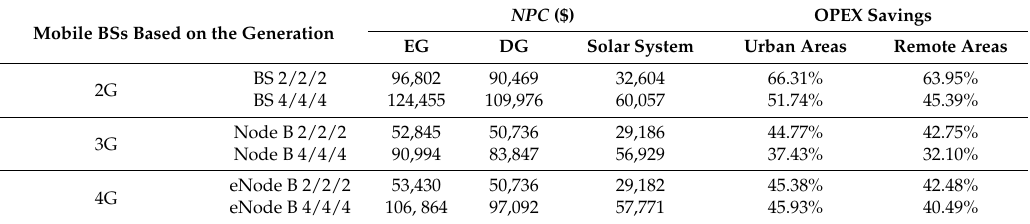
Table 4. Operational expenses (OPEX) savings for the deployed solar-powered